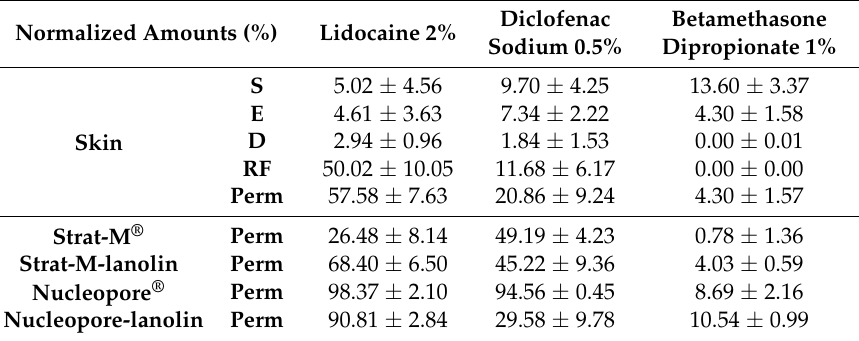
Table 4. Normalized amounts (%) found in the stratum corneum (SC), epidermis (E) dermis (D) and receptor fluid (RF). In the case of artificial membranes, skin permeation (Perm) belongs to the amounts found in the receptor fluid.